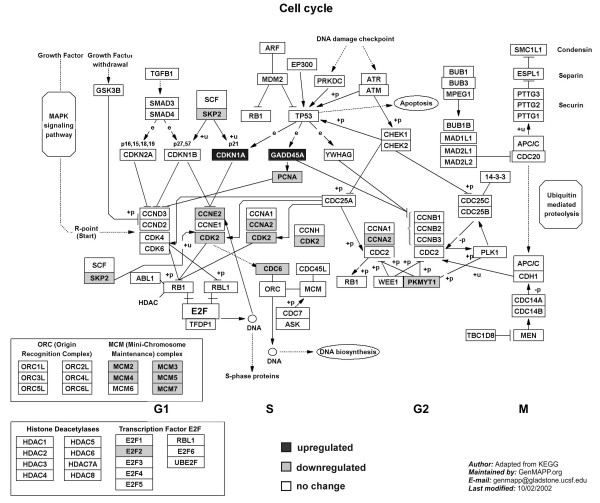
Cell cycle pathway diagram obtained from GenMAPP (Gene Map Annotator and Pathway Profiler, Gladstone Institutes, University of San Francisco, San Francisco, CA [38]. Proteins involved in cell cycle control are displayed from left to right as cell cycle progresses from G1 through S and G2 to M-phase. Genes with boxes marked black were upregulated. Genes marked with grey boxes were downregulated.